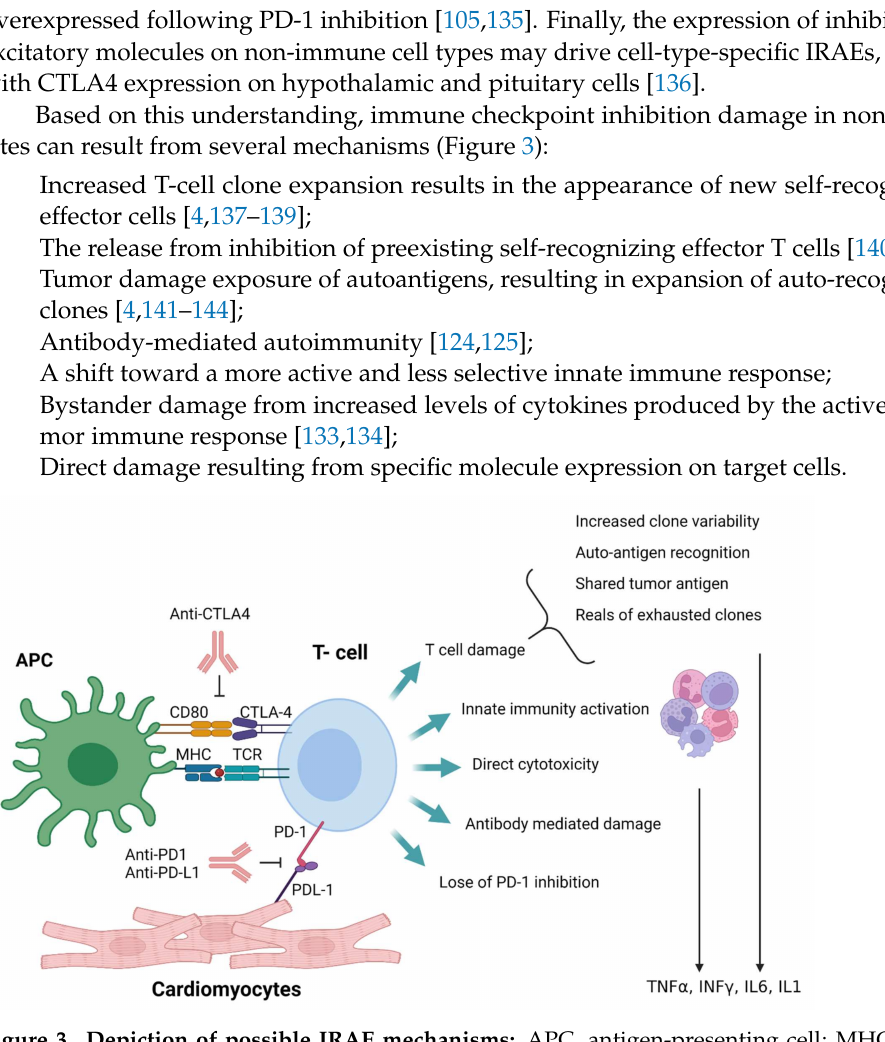
Figure 3. Depiction of possible IRAE mechanisms: APC, antigen-presenting cell; MHC, major histocompatibility complex; PD-1, programmed cell death protein 1; PD-L1, programmed death- ligand 1; CTLA-4, cytotoxic T-lymphocyte-associated protein 4; TCR, T-cell receptor; TNF α , tumor necrosis factor-alpha; INF γ , interferon-gamma; IL1, interleukin 1; IL6, interleukin